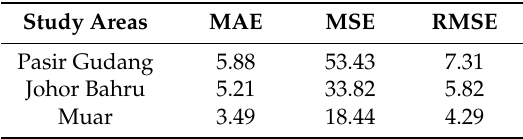
Table 13. Forecast accuracy in testing period of